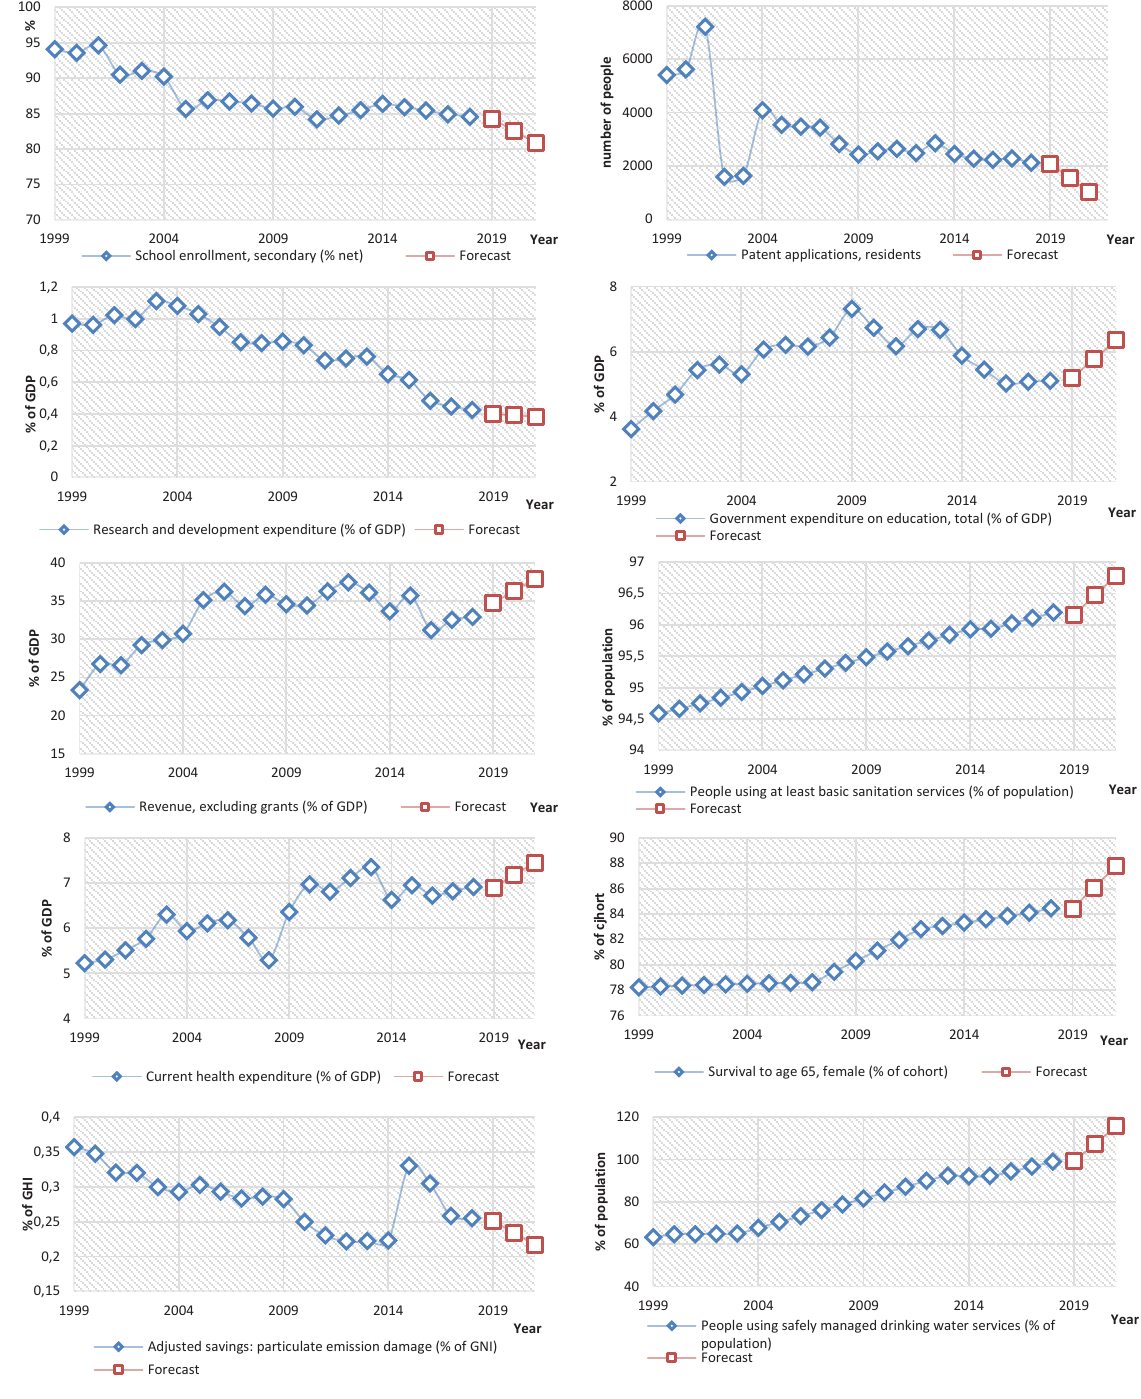
Figure B2. Graphical interpretation of retrospective and forecasted values of time series in the context of science and education, as well as environment and human health, for